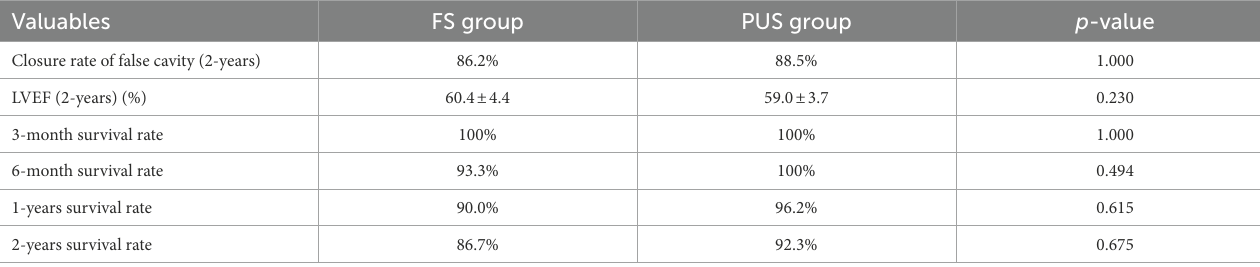
TABLE 4 Comparison of postoperative follow-up between the two groups. Valuables